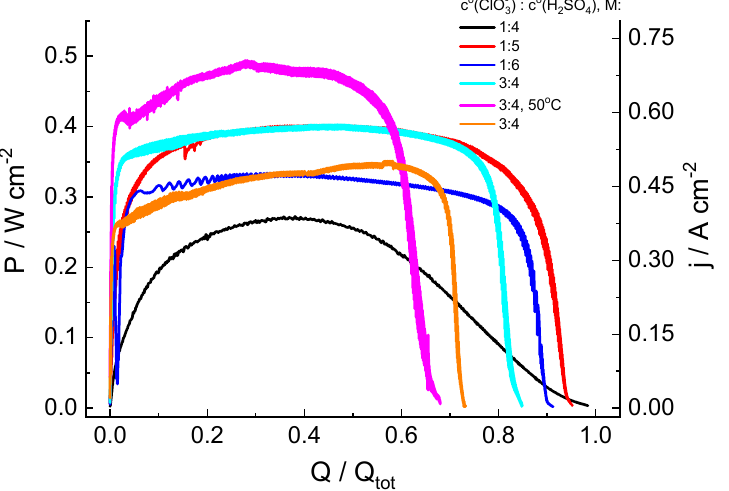
Figure 3. Discharge curves for hydrogen-chlorate MEA cells under a potentiostatic load of 0.7 V for catholyte solutions of various compositions: y M NaClO 3 + x M H 2 SO 4 (y = 1 or 3; x = 4, 5 or 6; indicated in legend for each graph). See Figure 1 for additional information.